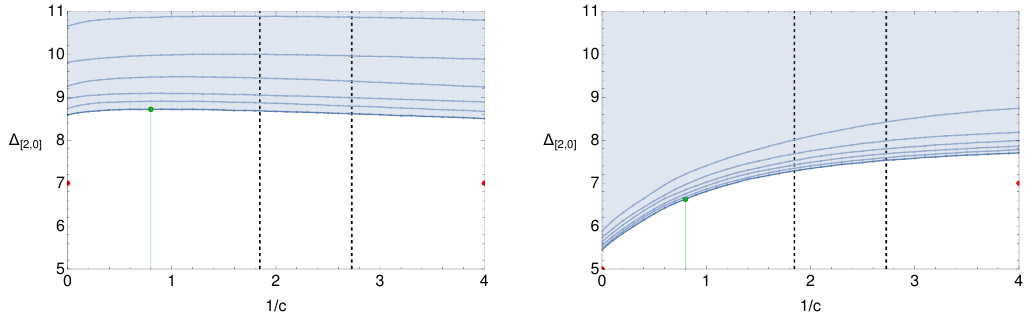
Figure 6 . Upper bound on the dimensions of the long multiplet A (cid:1) > 5 , allowing for (left) and [2 ; 0] ; 10 ; 0 disallowing for (right) the short multiplet (cid:22) B . The strongest bound corresponds to 24 derivatives, [2 ; 2] and they are reduced in steps of two. The red dots mark the dimension of the (cid:12)rst long operators for generalized free (cid:12)eld theory and U(1) N = 4 SYM, in the right plot the red dot of generalized free (cid:12)eld theory is at the unitarity bound, meaning that the short multiplet is present in this solution. The green line marks the central charge c = 15 of the simplest known N = 3 SCFT, with the green 12 dot providing an upper bound for this theory. The two dashed lines correspond to the minimum central charges for an interacting N = 2 [47] and N = 3 SCFTs